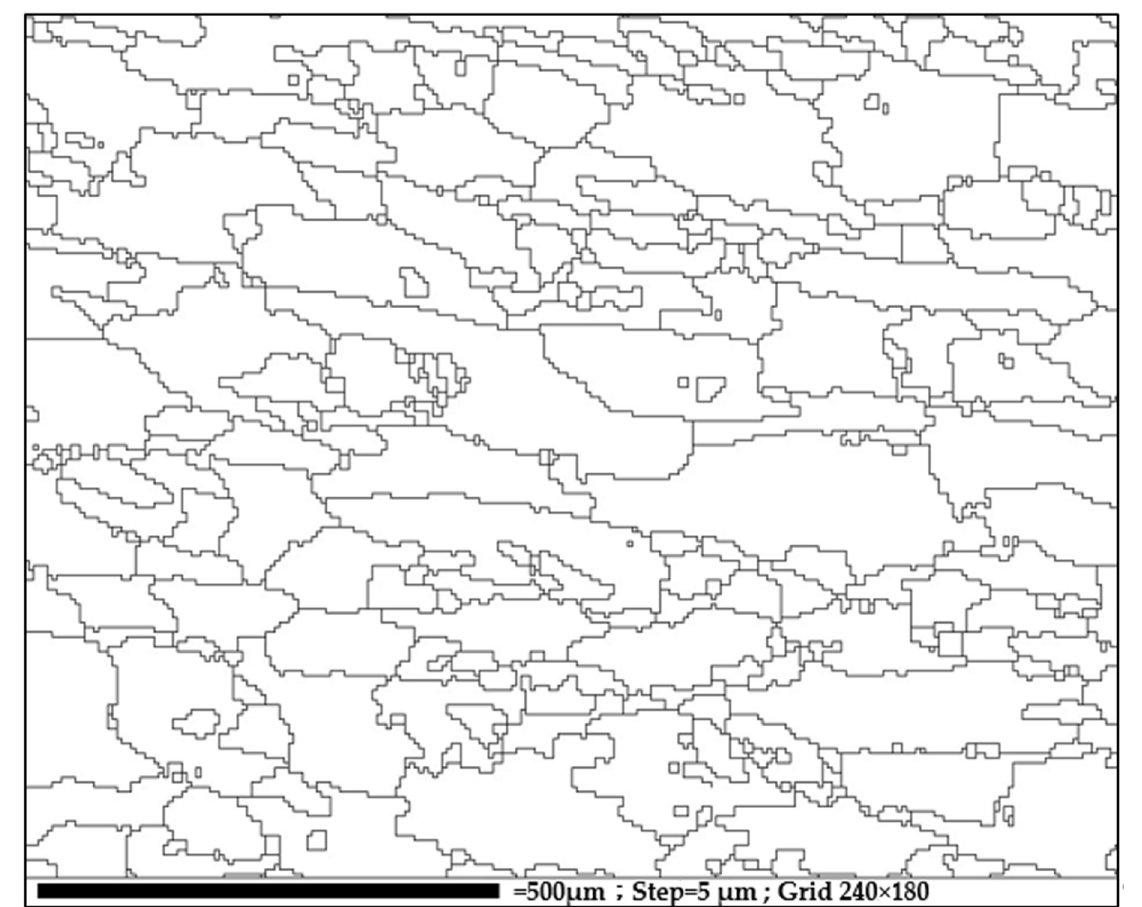
Figure 10. High angle grain boundaries (>15 ◦ ) measured from RF50. Table 5. Total Grain Boundary Lengths Per Unit Area (mm/mm 2 ) for Different Samples.